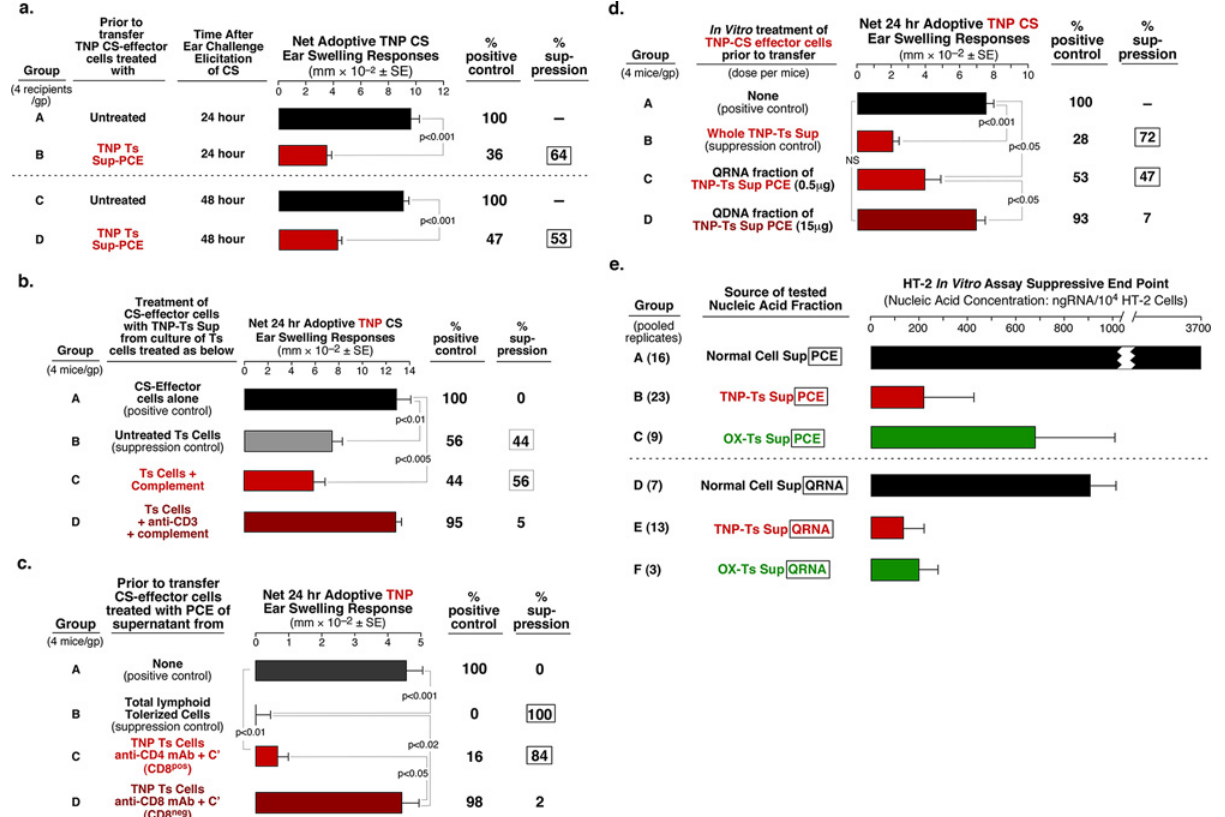
Fig 1. RNA from Phenol-Chloroform Extract (PCE) and Qiagen column fraction (QRNA) from CD3+ CD8+ suppressor T lymphocyte (Ts) culture supernatant (Sup) is suppressive. a. PCE from TNP Ts Sup suppresses the adoptive transfer of CS-effector cells (Groups B and D). b . Treatment of Ts cells with anti-CD3 mAb plus complement (C ’ ) eliminates production of suppressive Sup (Group D). c. Similar treatment of Ts cells with anti-CD8 mAb plus C ’ also eliminates generation of suppressive Sup (Group D), while anti-CD4 mAb plus C ’ treatment does not (Group C). d. QRNA from TNP Ts Sup PCE separated on a Qiagen column suppresses adoptively transferred CS, while the QDNA fraction is inactive (Group C vs D). e. TNP- and OX-specific Ts Sup- derived PCE (Groups B and C) and QRNA (Groups E and F) inhibit HT-2 cell in vitro responsiveness to IL-2, compared to Nl Cell Sup PCE and QRNA (Groups A and D).